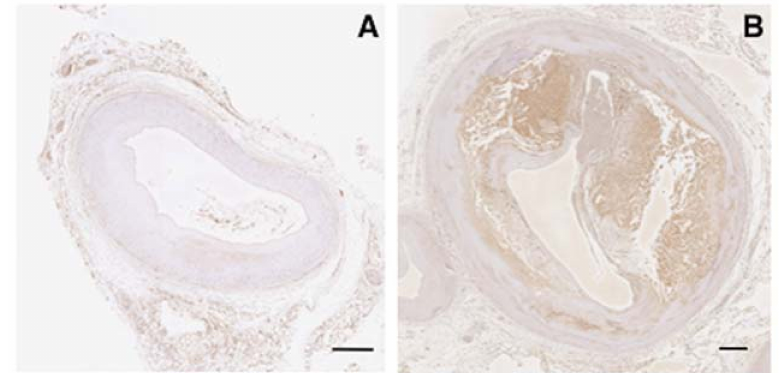
Figure 1. Immunohistological expression of vaspin in human coronary arteries from a non-CAD patient (male, 39 years old, dilated cardiomyopathy; ( A )) and a CAD patient (male, 80 years old, acute myocardial infarction; ( B )). Bar = 500 µ m.